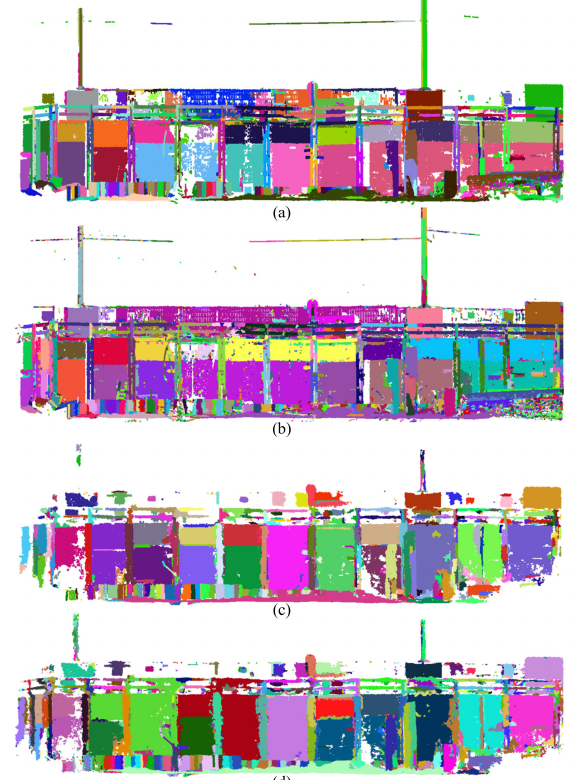
Figure 8. Segmentation results of construction site using (a) VGS and (b) SVGS methods with LiDAR dataset, and using (c) VGS and (d) SVGS methods with photogrammetric